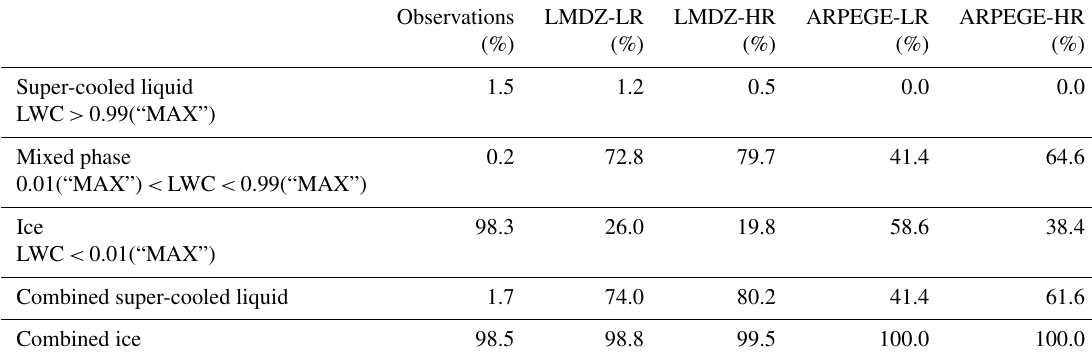
Figure 11. Difference bivariate histograms for F7 of ice water content vs. pressure between ARPEGE and LMDZ for (a) LR differences in “potential” ice water content (cloud ice plus snow) only (Fig. 10b–d), (b) HR differences in “potential” ice water content only (Fig. 10c–e), (c) LR differences in “maximum” ice water content (ice water content plus liquid water content) (Fig. 10k–m), and (d) HR differences in “maximum” ice water content (Fig. 10l–n). Reds refer to ARPEGE having a larger quantity and blues for LMDZ. The colour scale applies to all panels. The hindcasts are initiated at 00:00UTC 1 October 2016 and use the nearest grid point to the flight path from the two times surrounding the flight path (12:00 and 15:00UTC 2 October 2016; T + 36–39h). Table 3. The fraction of points within F7 that have values deemed as super-cooled liquid, mixed phase, and ice. “MAX” equals IWC plus LWC, combined super-cooled liquid equals super-cooled liquid plus mixed phase, and combined ice equals ice plus mixed phase. The hindcasts are initiated at 00:00UTC 1 October 2016 and use the nearest grid point to the flight path from the two times surrounding the flight path (12:00 and 15:00UTC 2 October 2016; T + 36–39h). Observations LMDZ-LR LMDZ-HR ARPEGE-LR